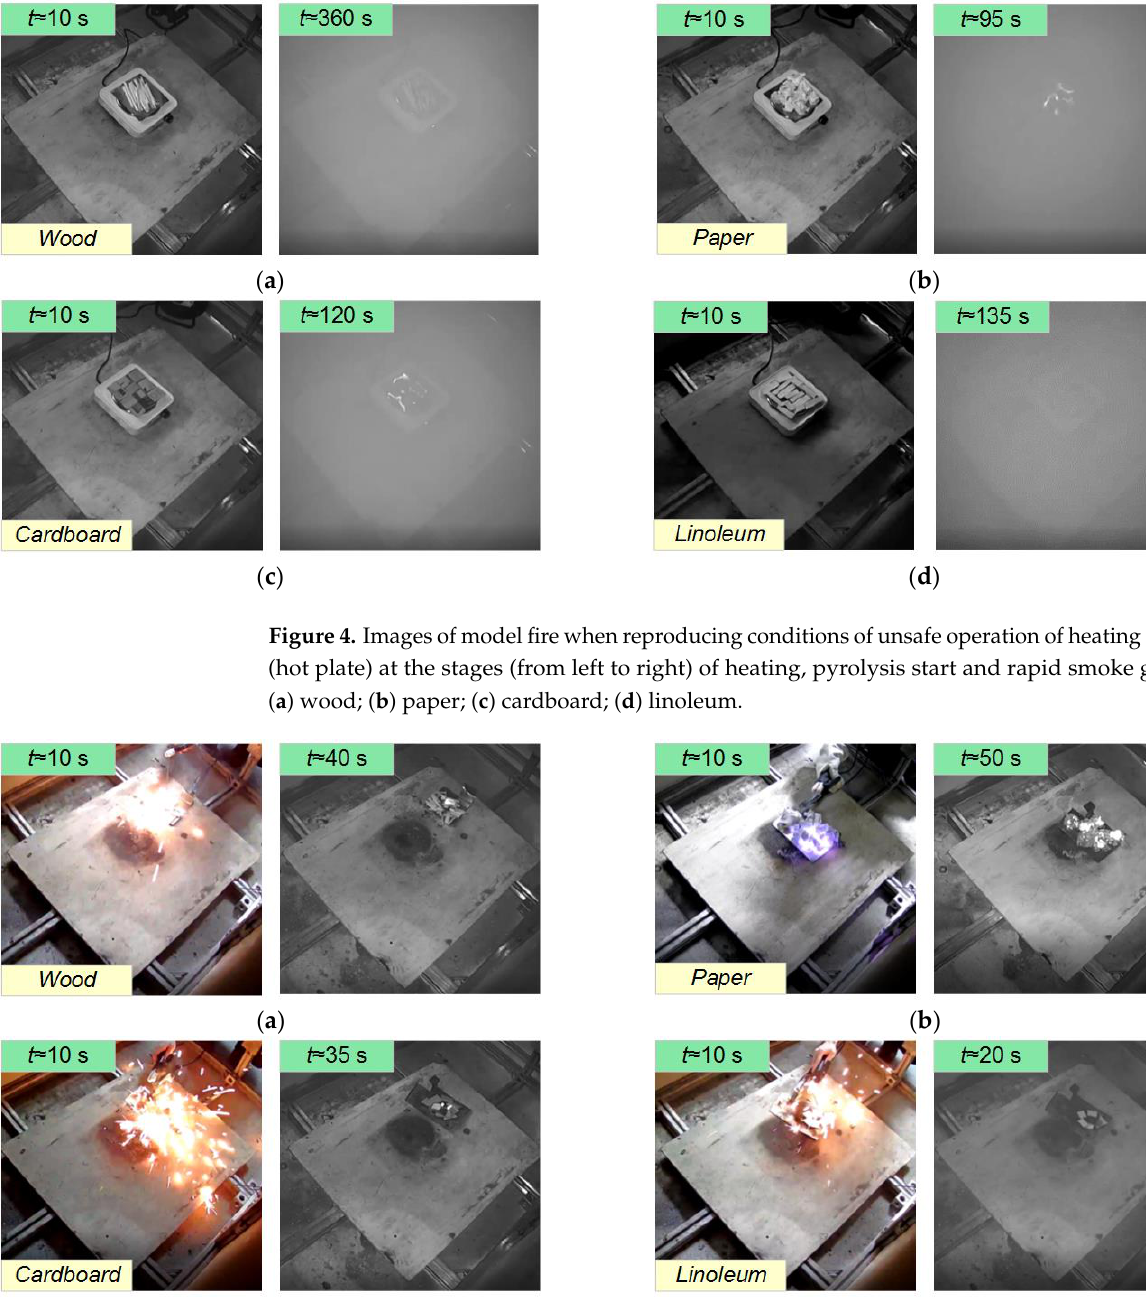
Figure 3. Images of model fire when reproducing conditions of careless handling of fire (gas burner) at the stages (from left to right) of ignition, rapid flame combustion, smoldering start and smoldering completion: ( a ) wood; ( b ) paper; ( c ) cardboard; ( d ) linoleum.